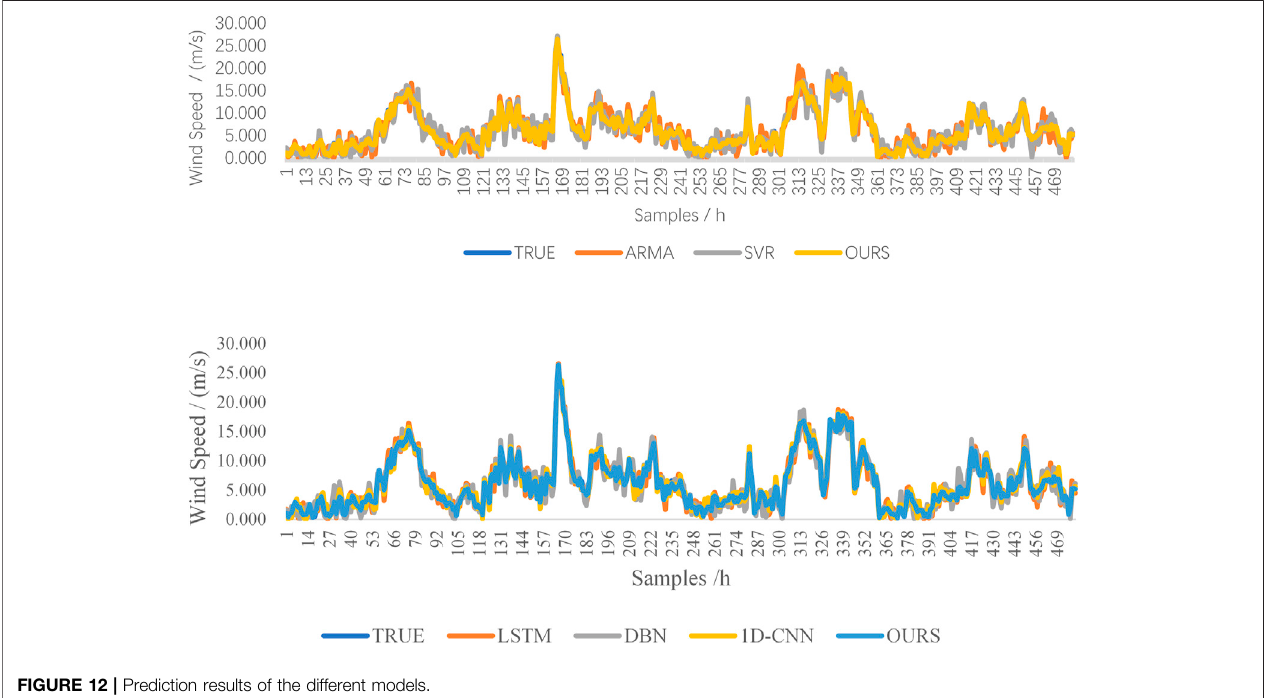
FIGURE 12 | Prediction results of the different models.